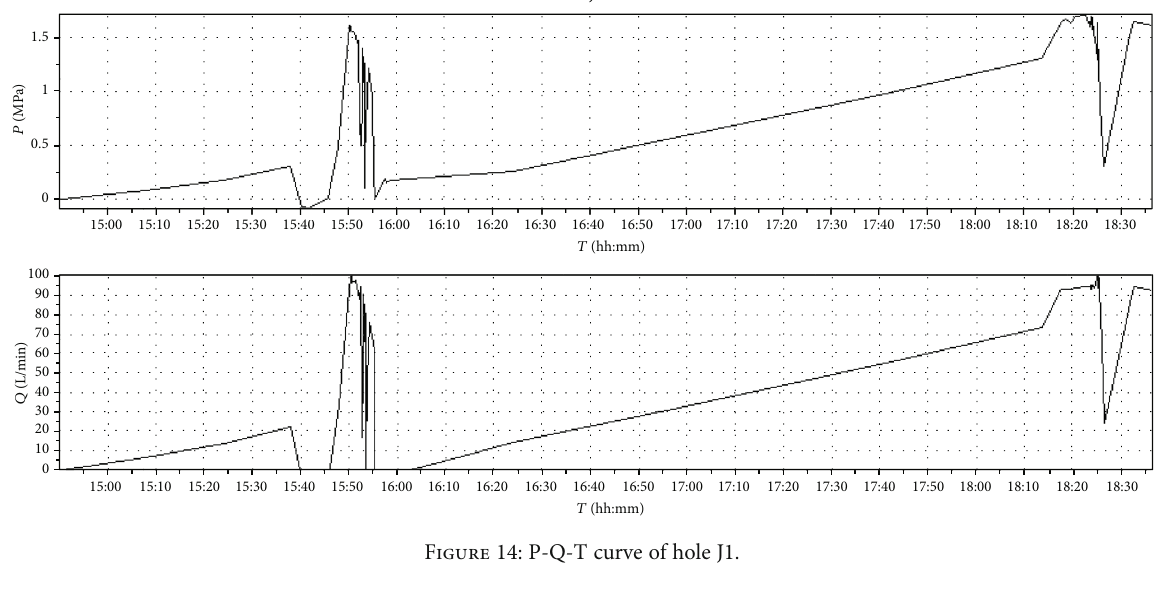
Figure 14: P-Q-T curve of hole J1.